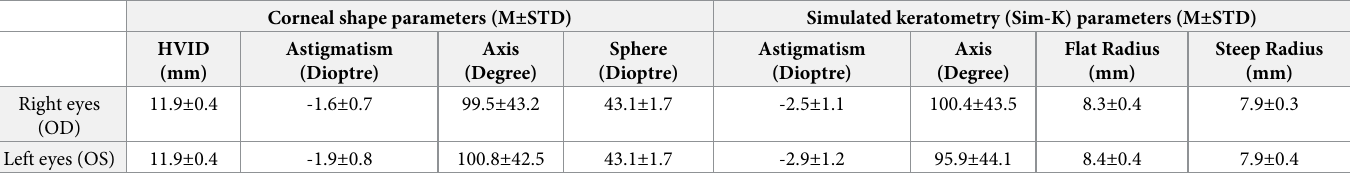
Table 2. Participants’ eye shape clinical parameters as measured by the